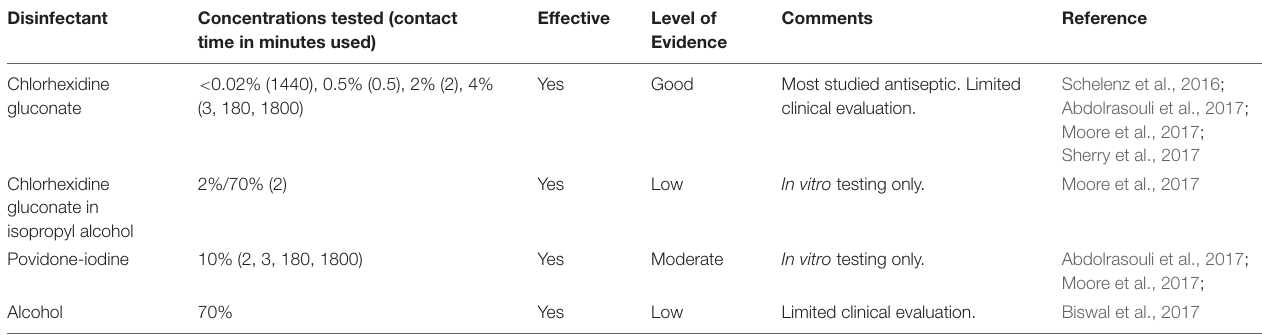
TABLE 3 | Antiseptics tested against C. auris . Disinfectant Concentrations tested (contact time in minutes